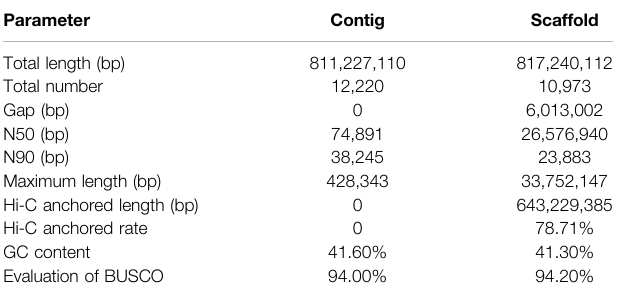
TABLE 1 | Statistics of the genome assembly of spiny head croaker. Parameter Contig